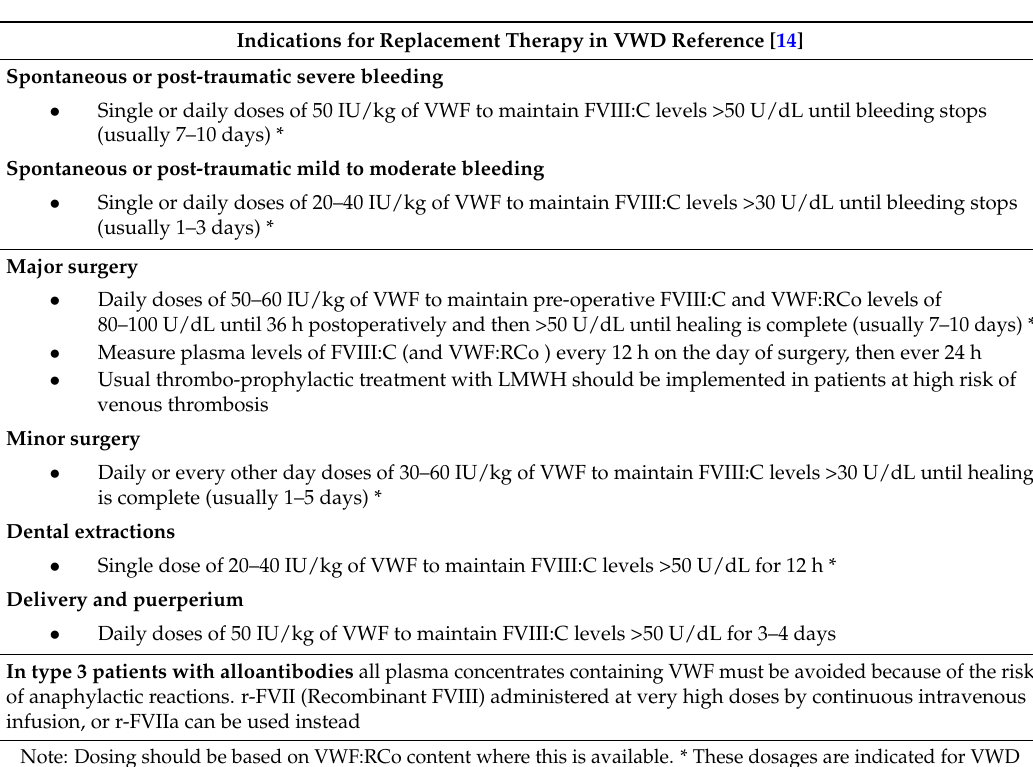
Table 4. Indications for replacement therapy in VWD Reference